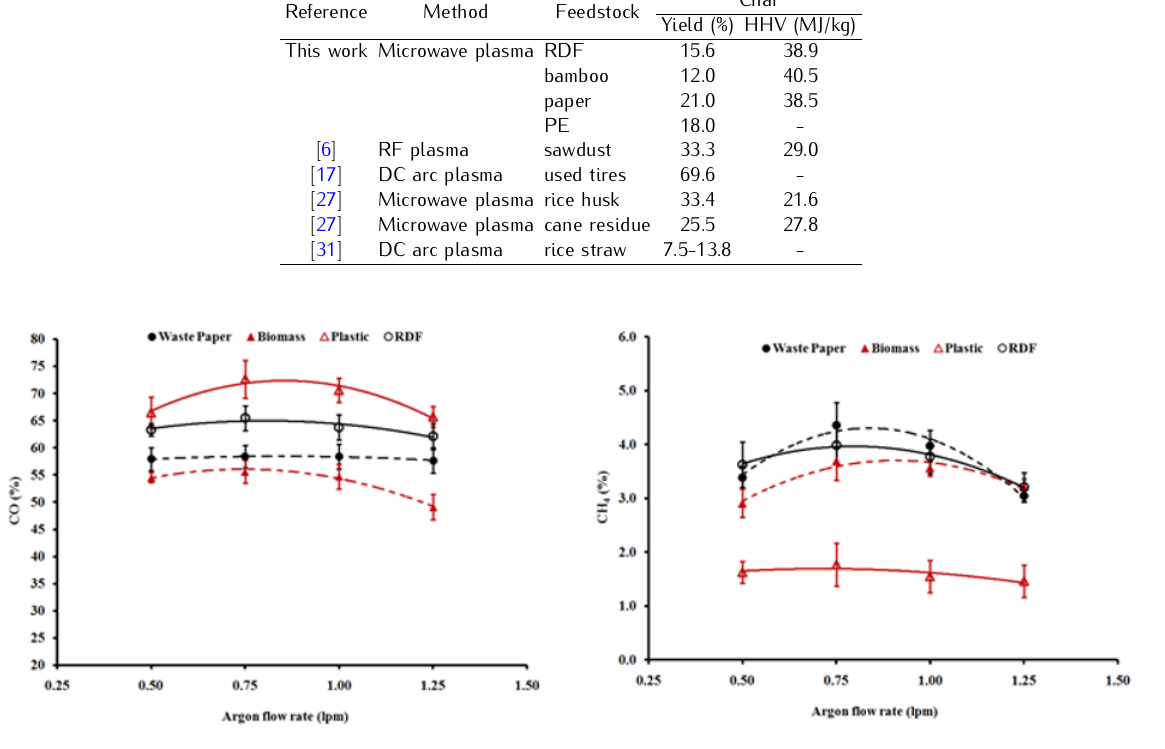
Figure 4. The variation in the CH 4 evolution with the carrier gas flow rate and the type of